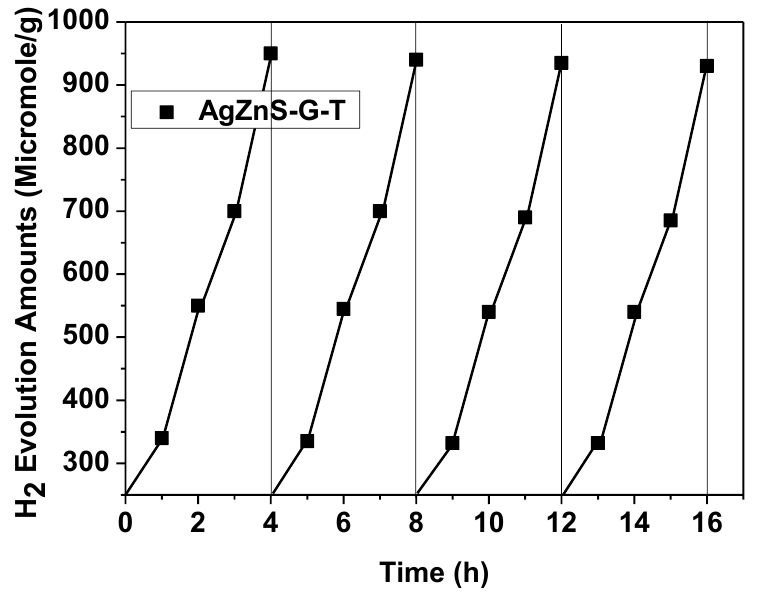
Figure 9. H 2 evolution of the circle test of AgZnS-G-T photocatalyst.